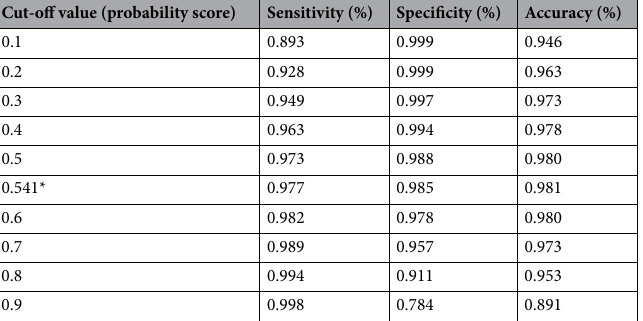
Cut-off value (probability score) Sensitivity (%) Specificity (%) Accuracy